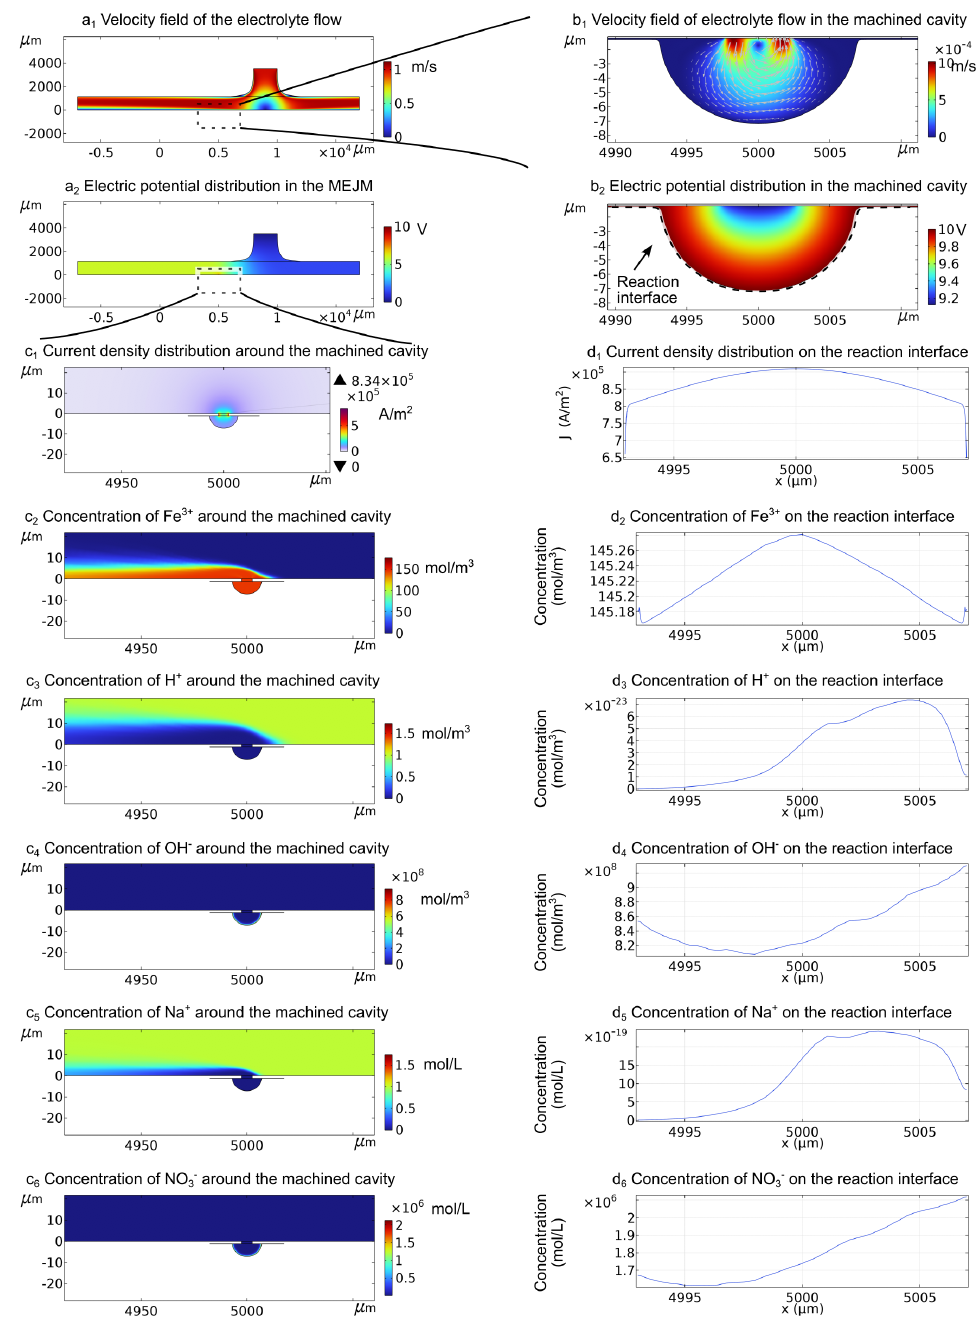
Figure A4. Simulation results at t = 3 s. ( a 1 ): velocity field of the electrolyte flow; ( b 1 ): velocity field of electrolyte flow in the machined cavity; ( a 2 ) electric potential distribution in the MEJM; ( b 2 ) electric potential distribution (V) in the machined cavity; ( c 1 ) normal current density distribution around the machined cavity; ( d 1 ): normal current density distribution on the reaction interface; ( c 2 – c 6 ): concentration ( mol/m 3 ) of Fe 3+ , H + , OH – , Na + , and NO 3– around the machined cavity; ( d 2 – d 6 ): concentration (mol/m 3 ) of Fe 3+ , H + , OH – , Na + , and NO 3– on the reaction